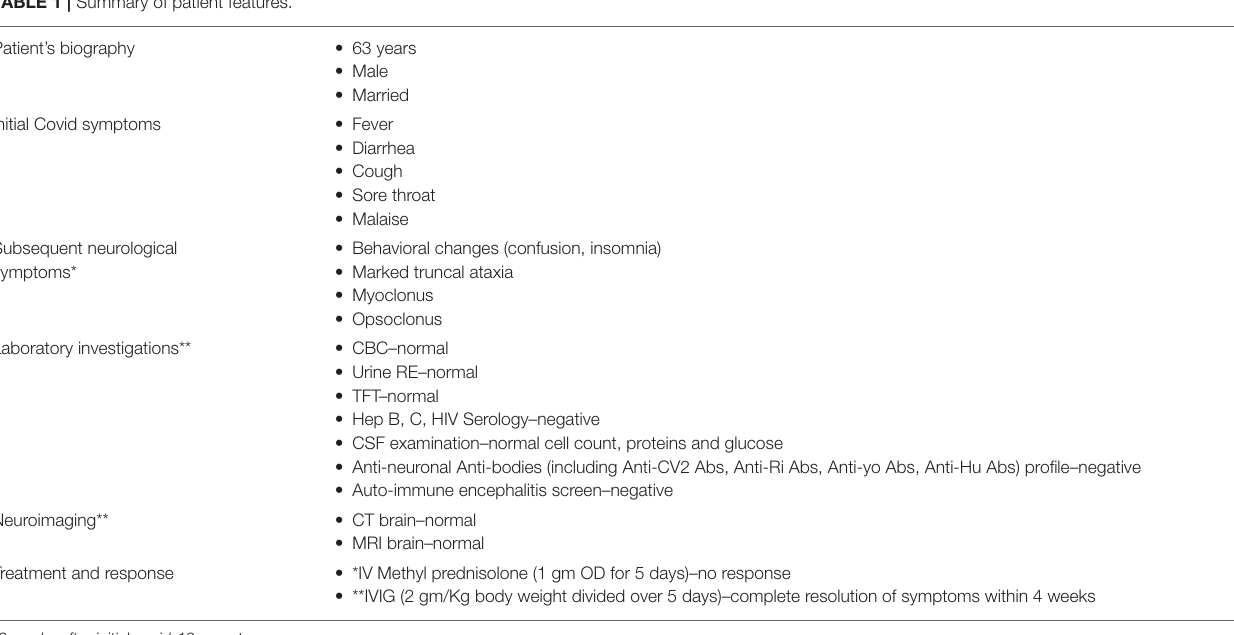
TABLE 1 | Summary of patient